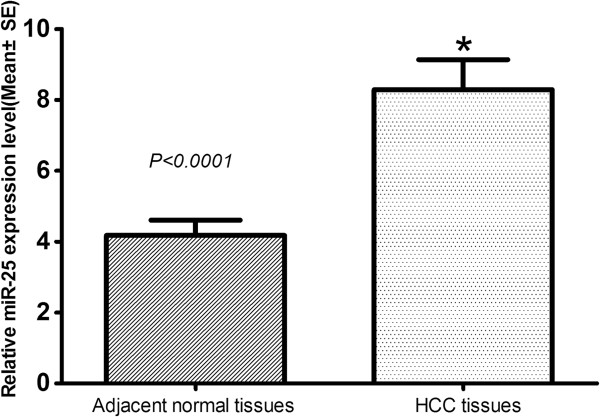
Comparison of miR-25 expression levels between hepatocellular carcinoma tissues and adjacent normal tissues. Analysis using the two sample Student’ s t test showed that the relative expression levels of miR-25 in the hepatocellular carcinoma tissues were significantly higher than those in adjacent normal tissues (p<0.0001) SE, Standard Error.